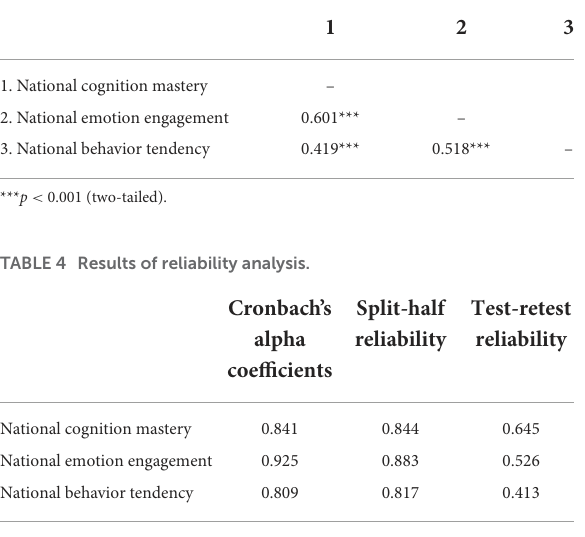
TABLE 3 Correlations for three dimensions.